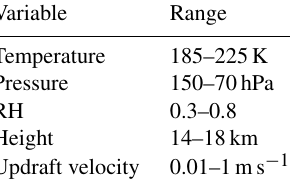
Table 2. Parameters used to plot the aerosol size distributions in Fig. 2, where the size distributions 1, 2 and 3 correspond to the studies by Yu et al. (2017), Möhler et al. (2008) and Wagner et al. (2017) respectively.